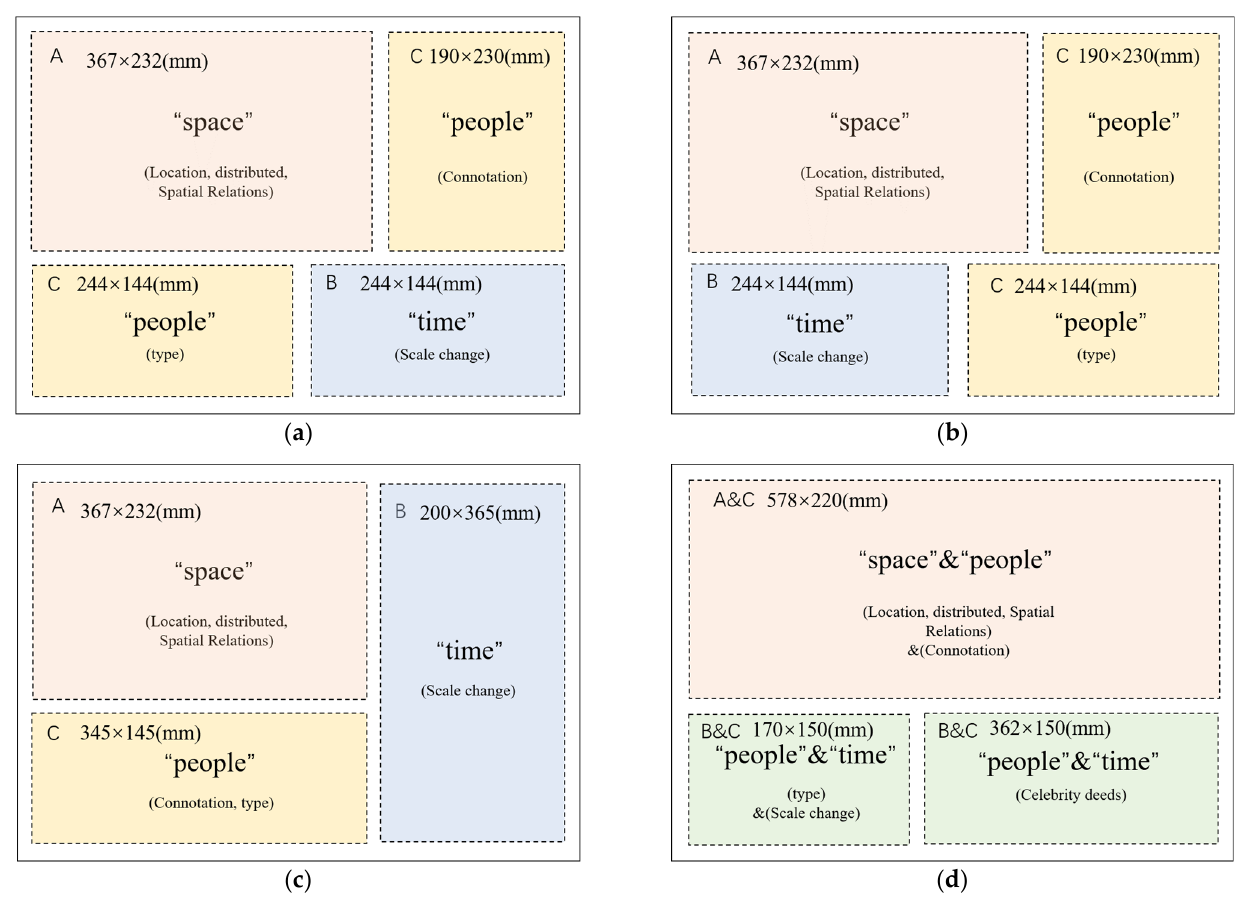
Figure 6. Layout settings for the layout system: ( a ) famous buildings layout; ( b ) famous products layout; ( c ) traditional customs layout; ( d ) famous people and events layout. layout; ( c ) traditional customs layout; ( d ) famous people and events